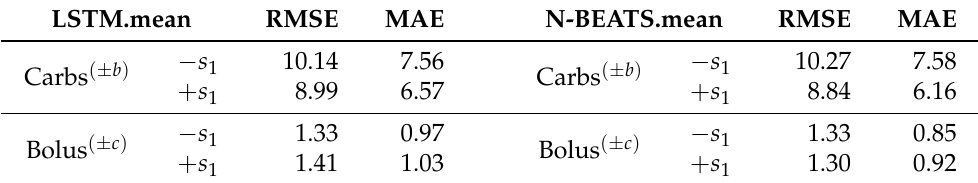
Table 7. Performance of the LSTM- and N-BEATS-based models, with ( + ) and without ( − ) the final state s 1 of LSTM 1 as part of the input to the FC Layers.